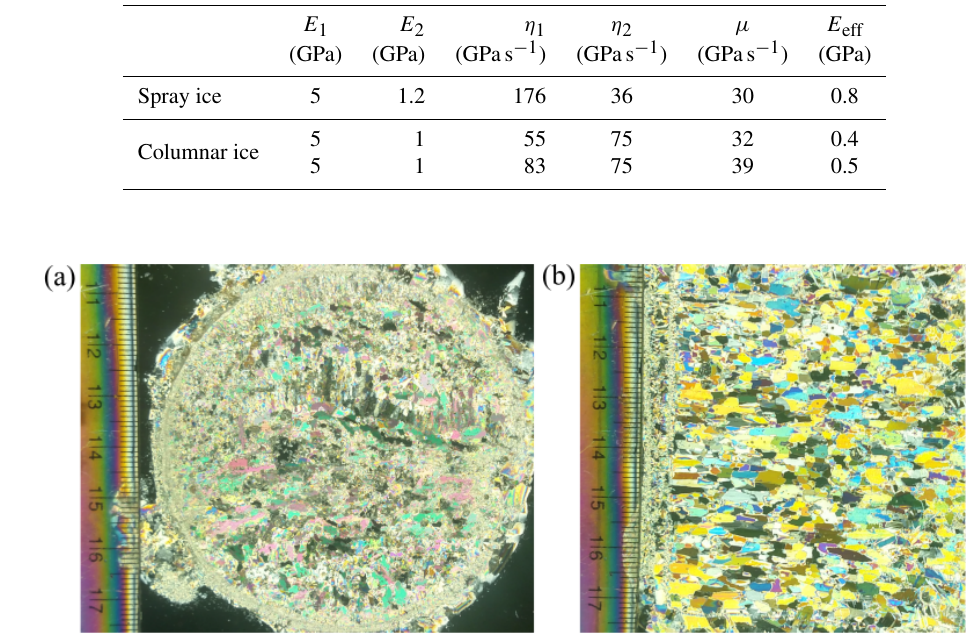
Figure B1. (a) Horizontal and (b) vertical thin sections of spray sea ice.